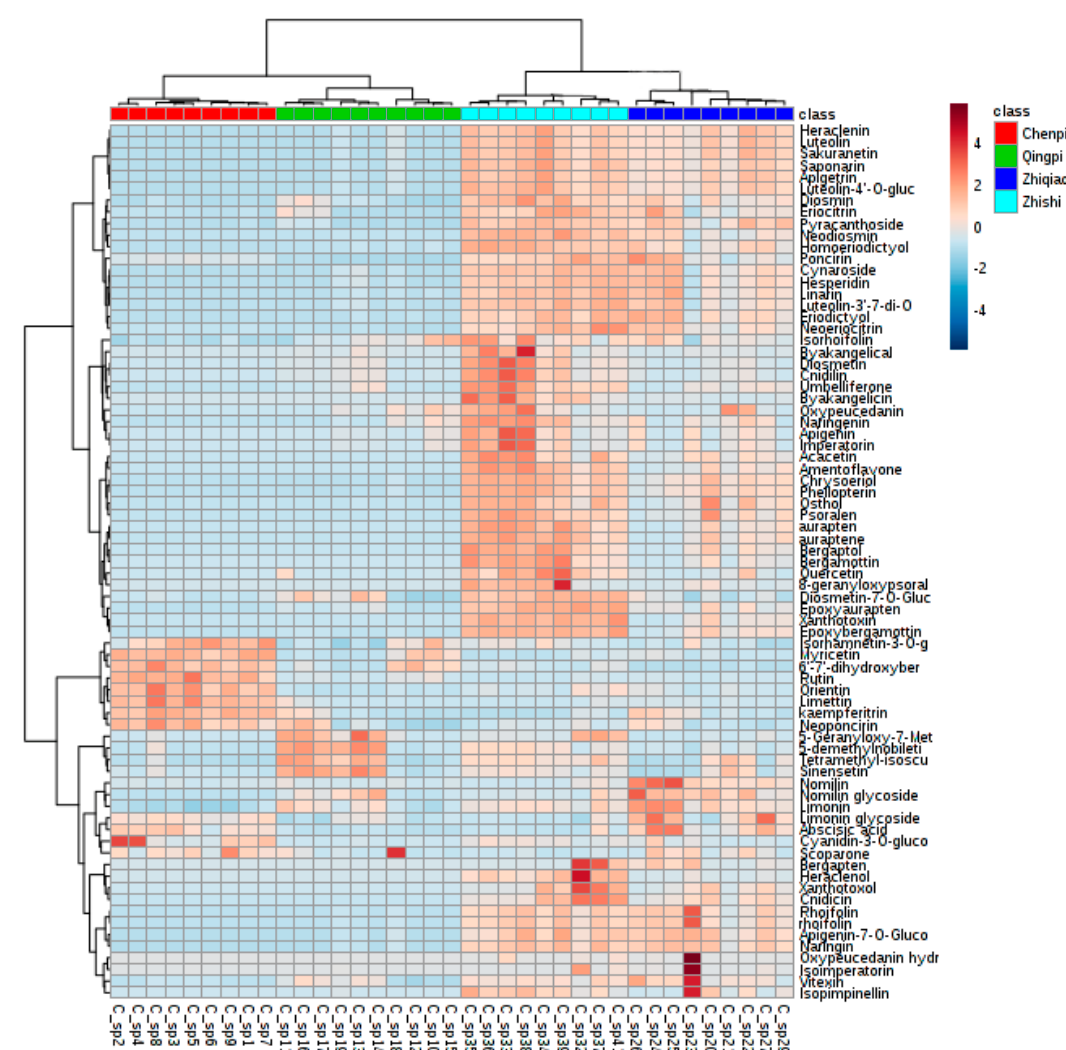
Figure 3. Heat-map of metabolite contents in Qingpi, Chenpi, Zhishi and Zhiqiao. The data are UV scaled.